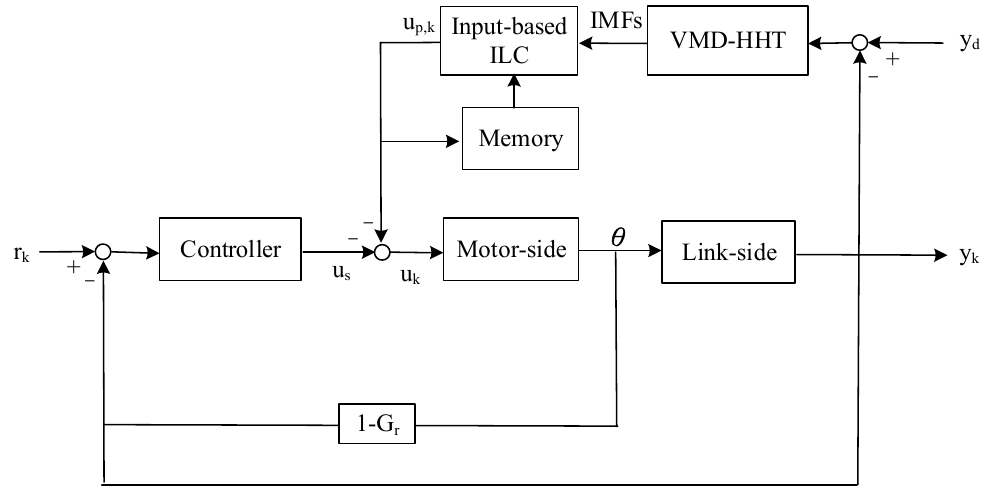
Figure 4. Block diagram of the input-based iterative learning control.